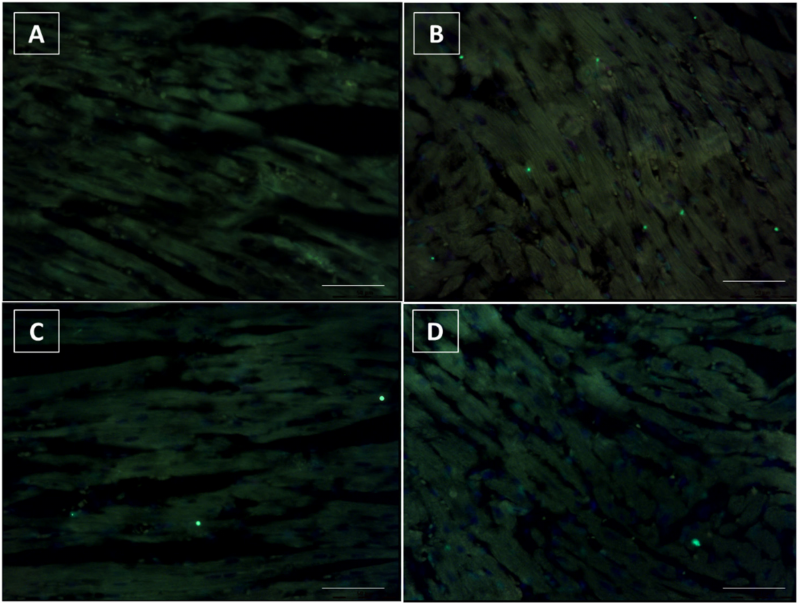
Figure 9. TUNEL assay indicating the fragmented DNA in tissue samples of untreated mice (saline) ( A ) or those treated with DOXO ( B ), Singo ( C ) or both in combination ( D ). Scale bar: 20 µ m.